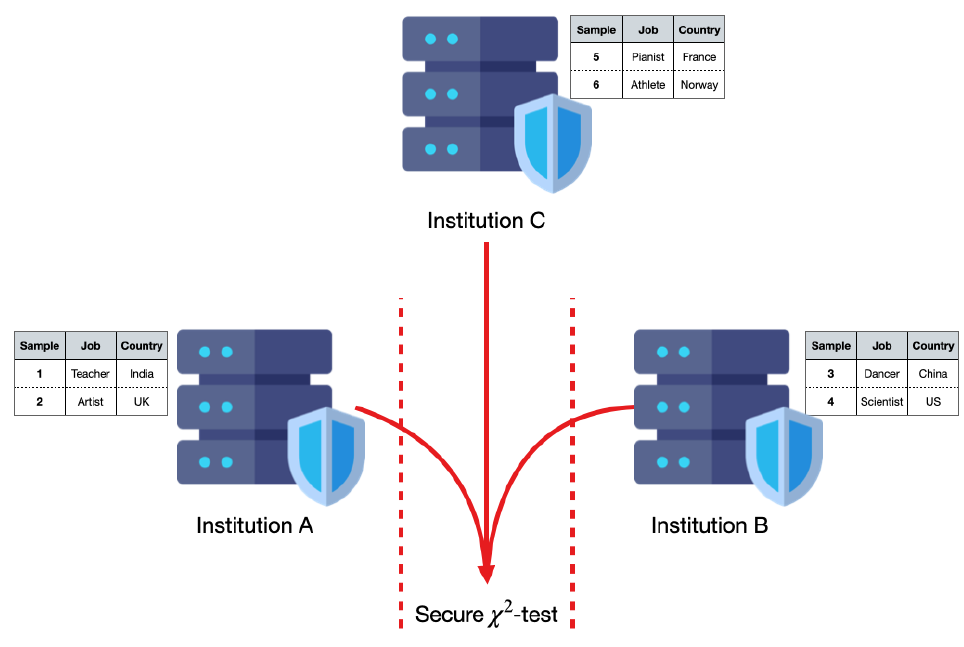
Figure 3. Federated setting for χ 2 -test. All the institutions own the same type of data, but for different sample IDs. They jointly do the federated analytics on all the samples without revealing any private data information to each other.